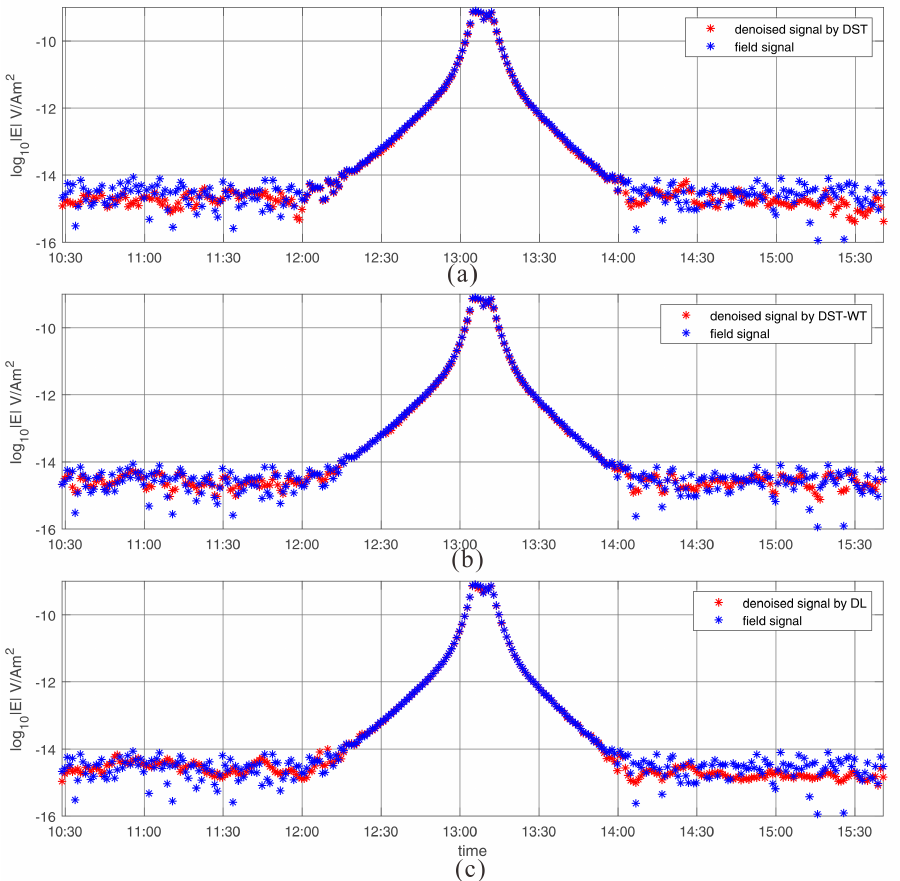
Figure 13. The MVT plots at frequency 1.5 Hz for field data. ( a ) is the denoising result under DST dictionary, ( b ) is the denoising outcome under DST-wavelet merged dictionary and ( c ) is the denoising result under learned